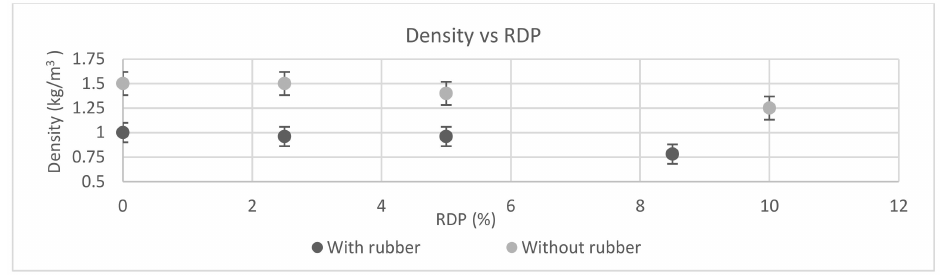
Figure 6. Hardened density for two tile adhesives with and without recycle rubber incorporation as a function of RDP content.